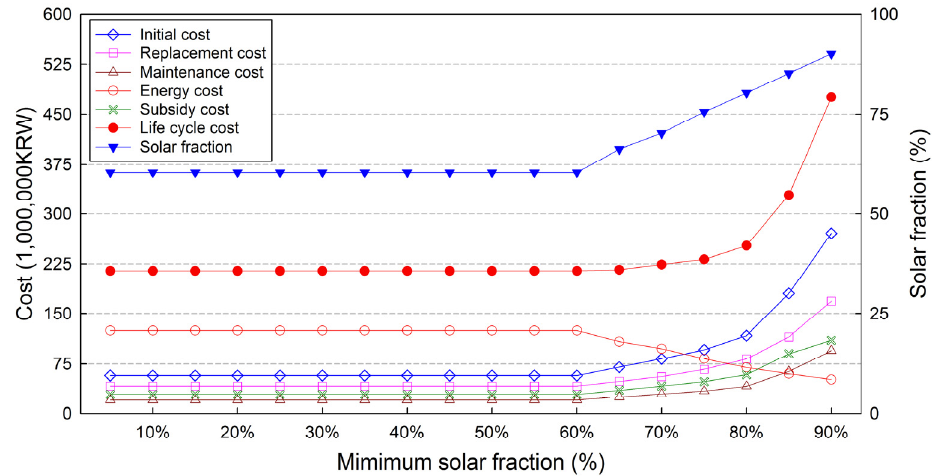
Figure 8. Variation of costs and solar fraction at the different minimum solar fractions.